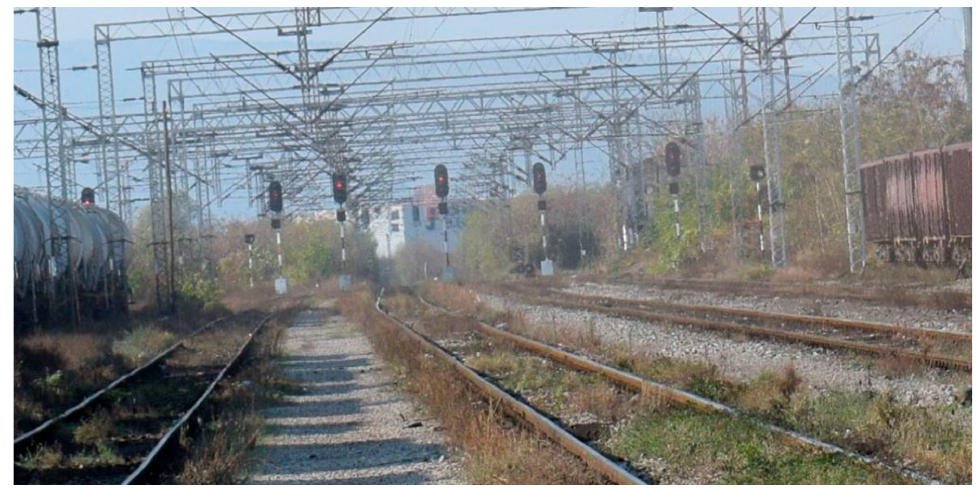
Figure 1. Railway infrastructure—multiple tracks and signals along the train path.